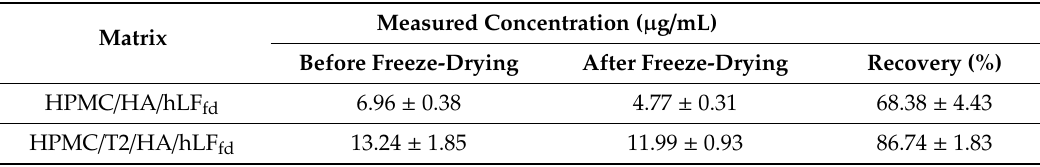
Table 6. hLF 1-11 recovery values from the selected formulations (Mean ± SE, n =